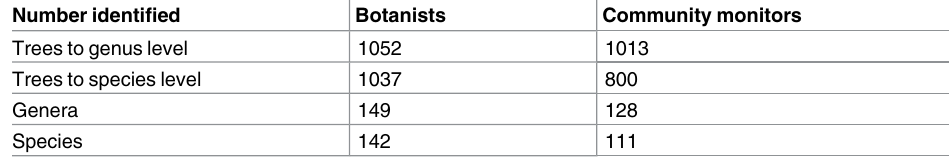
Table 2. Comparison of the number of trees identified to genus or species level by botanists and by community monitors, and the number of genera and species that the identified trees belonged to, in montane forest in Yunnan, China ( n = 1071 trees). Numbers for community monitors are calculated using only those with a one-to-one correspondence to scientific